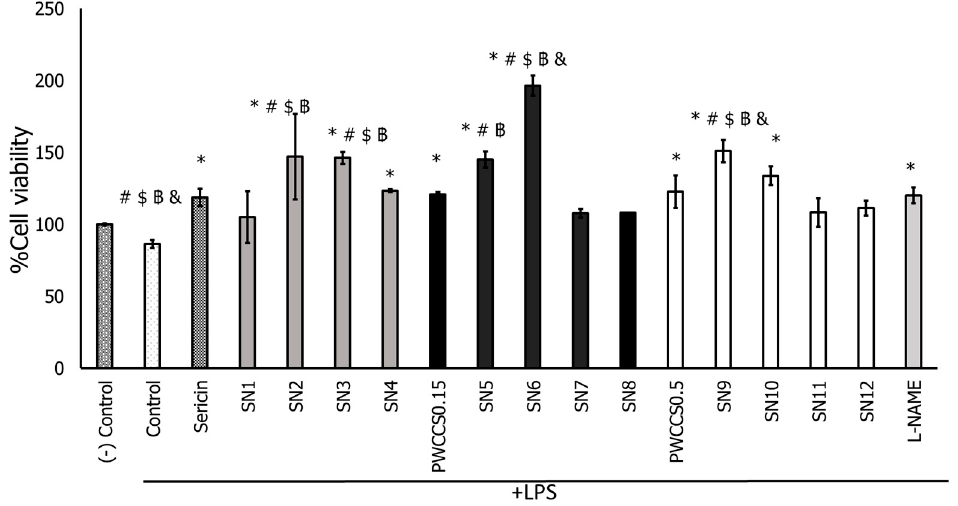
Figure 2. Effect of sericin, purple waxy corn cob extract solution 0.15 and 0.50% (PWCCS0.15 and PWCCS0.5), sericin-hydrogel formulations (SN1-SN12), and L-NAME 200 μ M (L-NAME) on cell